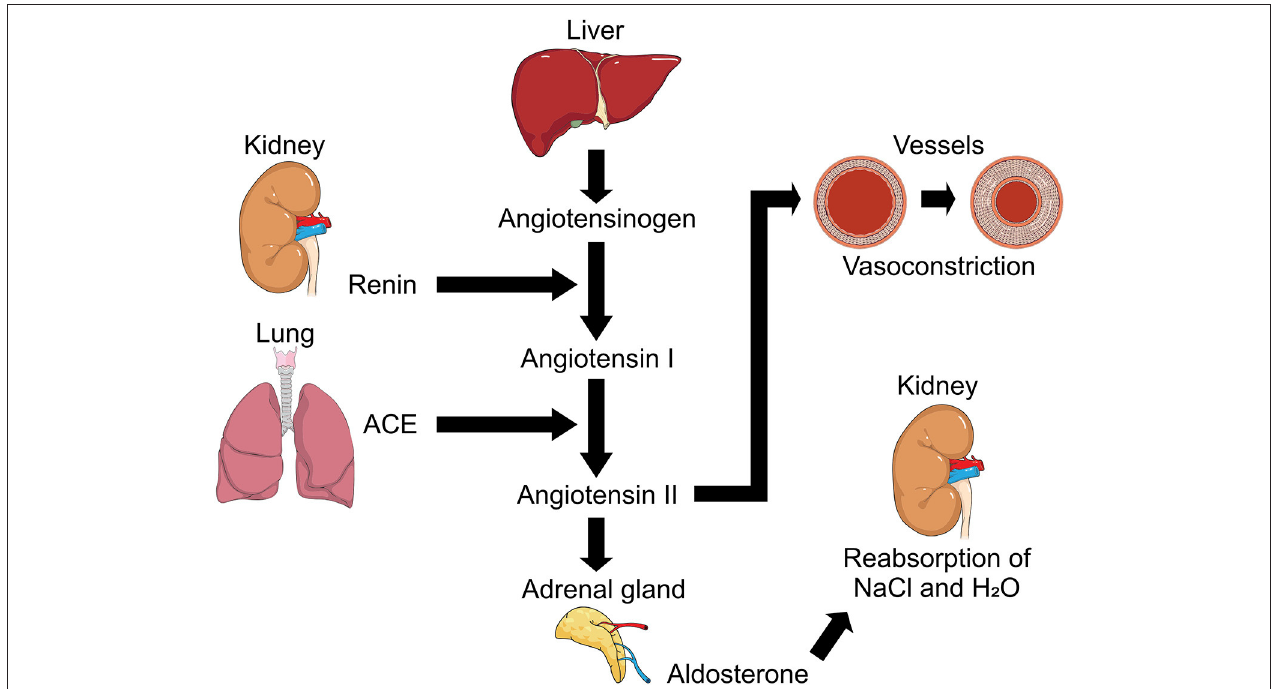
FIGURE 3 | Representation of Renin-Angiotensin-Aldosterone System (RAAS). Regulation mechanism of RAAS and its participation in processes such as the regulation of arterial tension due to its action on vessels causing vasoconstriction with angiotensin II participation, and hydroelectrolytic regulation with the intervention of aldosterone and its action in kidney. ACE, angiotensin converting enzyme; NaCl, sodium chloride (Salt); H 2 O,